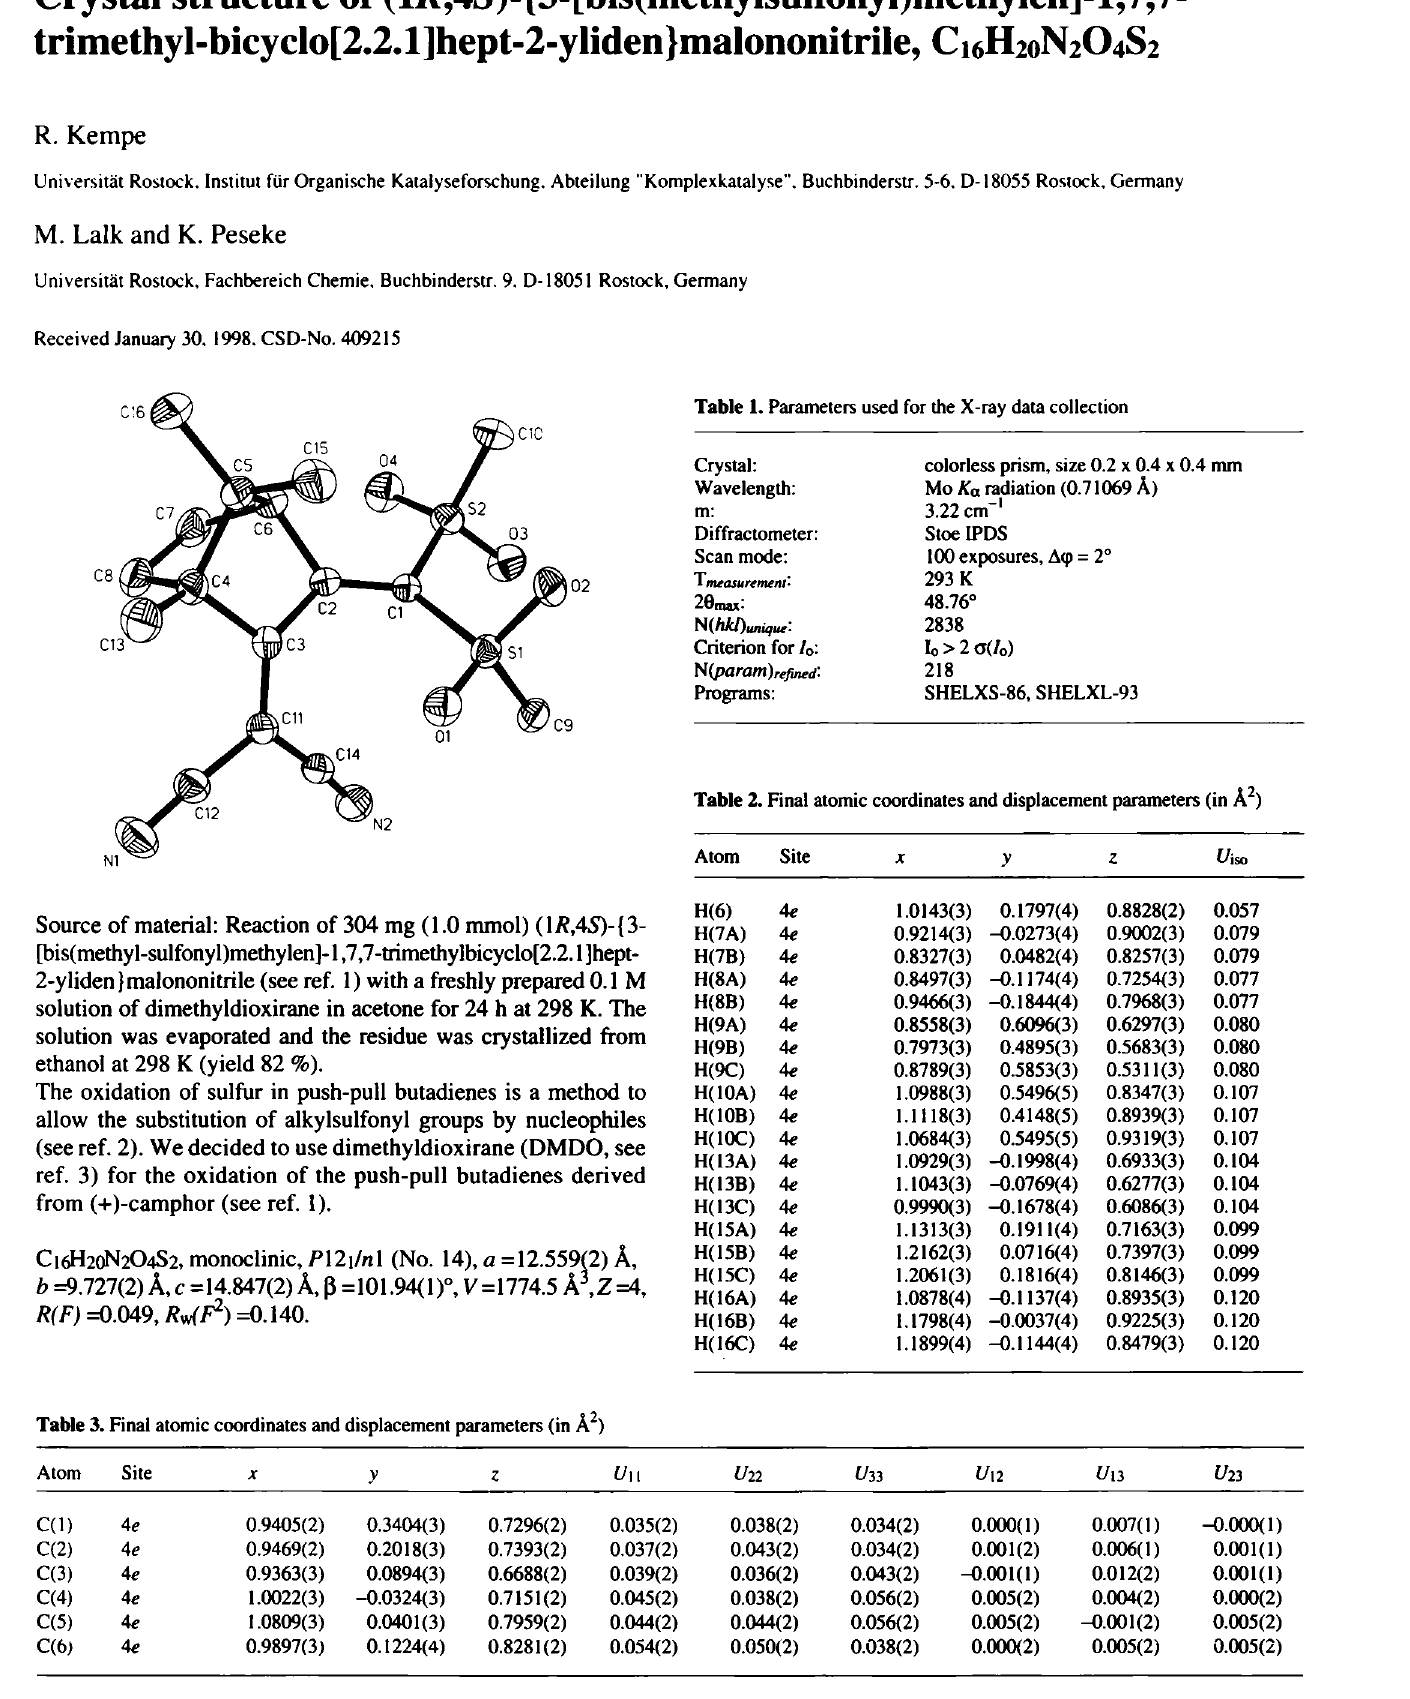
Table 3. Final atomic coordinates and displacement parameters (in Â^) Atom